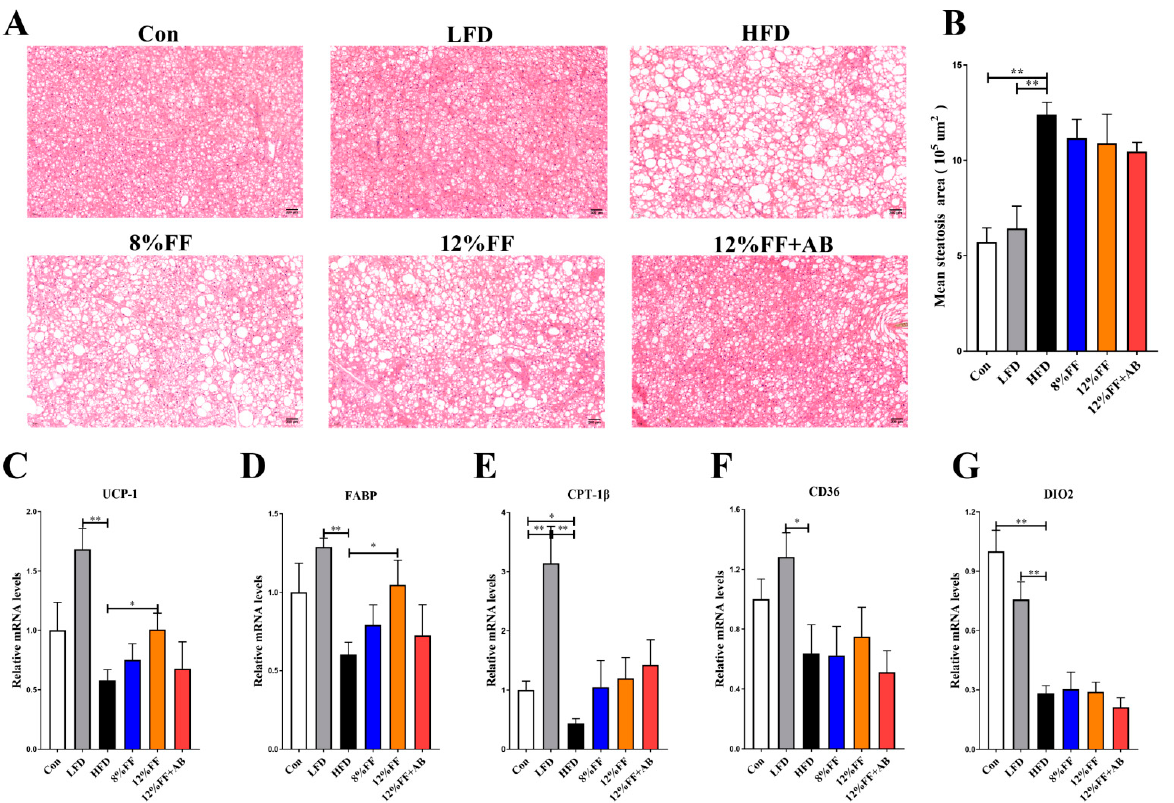
Figure 4. Effects of functional fiber on brown fat tissue thermogenesis in obese mice ( n = 7). ( A ) H&E staining analysis of brown adipose tissue of scapula (magnification: 200). ( B ) Lipid content in brown tissue of scapula. ( C – G ) mRNA expression of thermogenic genes involved in brown adipose tissue of scapula. The results are shown as the mean ± SEM. significant differences are expressed as * ( p < 0.05), and extremely significant differences are expressed as ** ( p < 0.01).